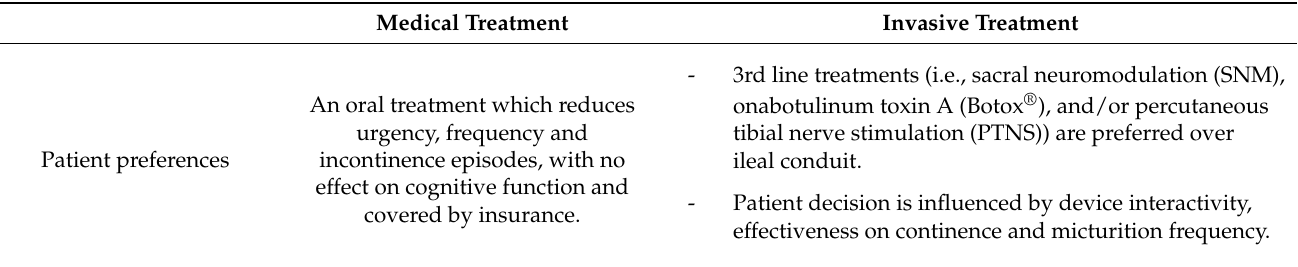
Table 2. Patients’ preferences and expectations regarding OAB management. Medical